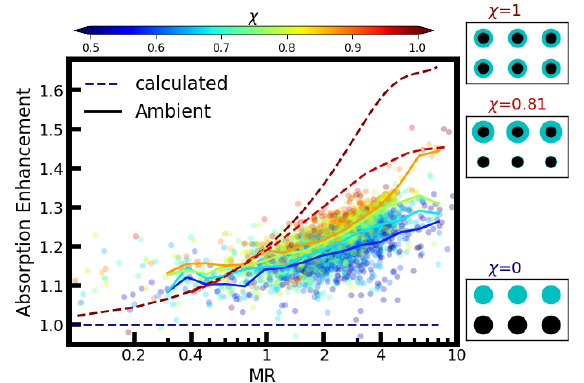
Figure 5. Relationship between the BC E abs and the measured mass ratio of the BC-containing aerosols coating material to BC under different χ conditions. The four solid lines from bottom to top cor- respond to the measured ambient size-resolved BC mixing states data with χ ranges of 0.575–0.625, 0.625–0.675, 0.675–0.725, and 0.725–0.775. The dotted line corresponds to χ values of 0.0 (blue), 0.81 (light red), and 1.0 (dark red), respectively.